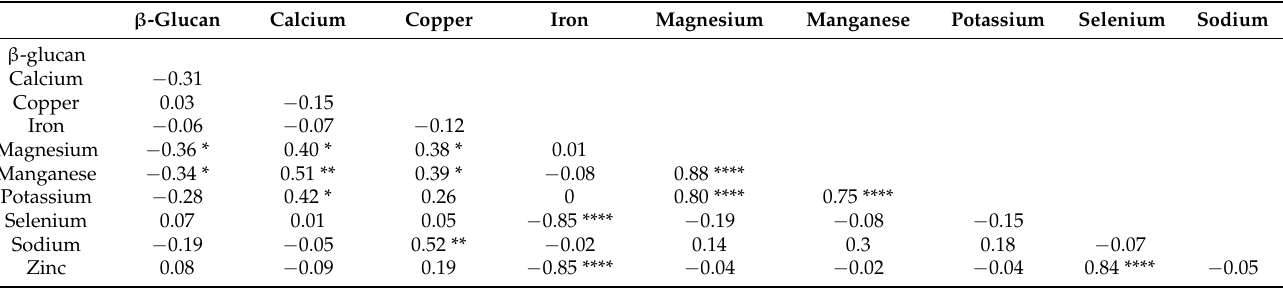
Table 8. Correlations among β -glucan and micronutrients contents elite germplasm and cultivars of cultivated barley.